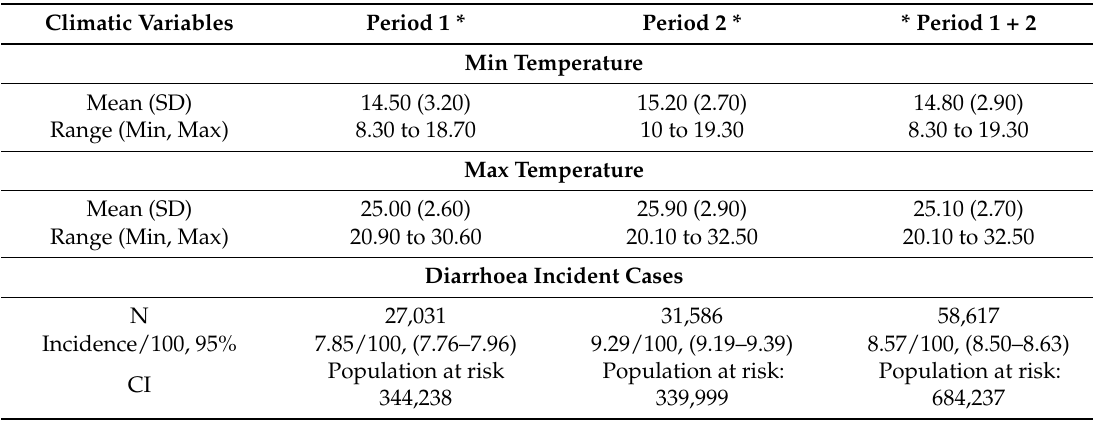
Table 1. Temperature variations and incidence of diarrhoea in two study periods.